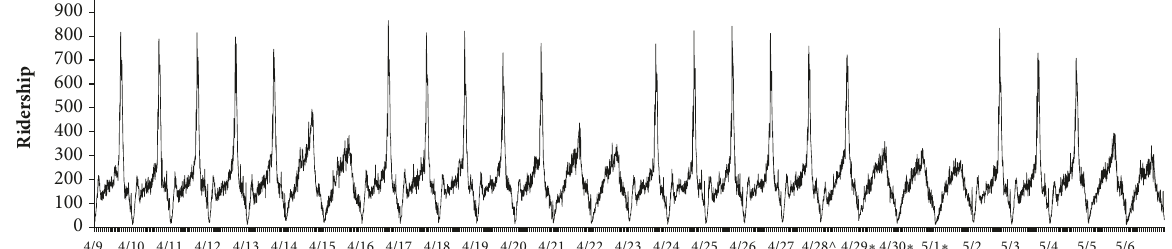
Figure 5: The origin entrance ridership time series at Zhujianglu Station of Nanjing Metro from April 9 to May 6,